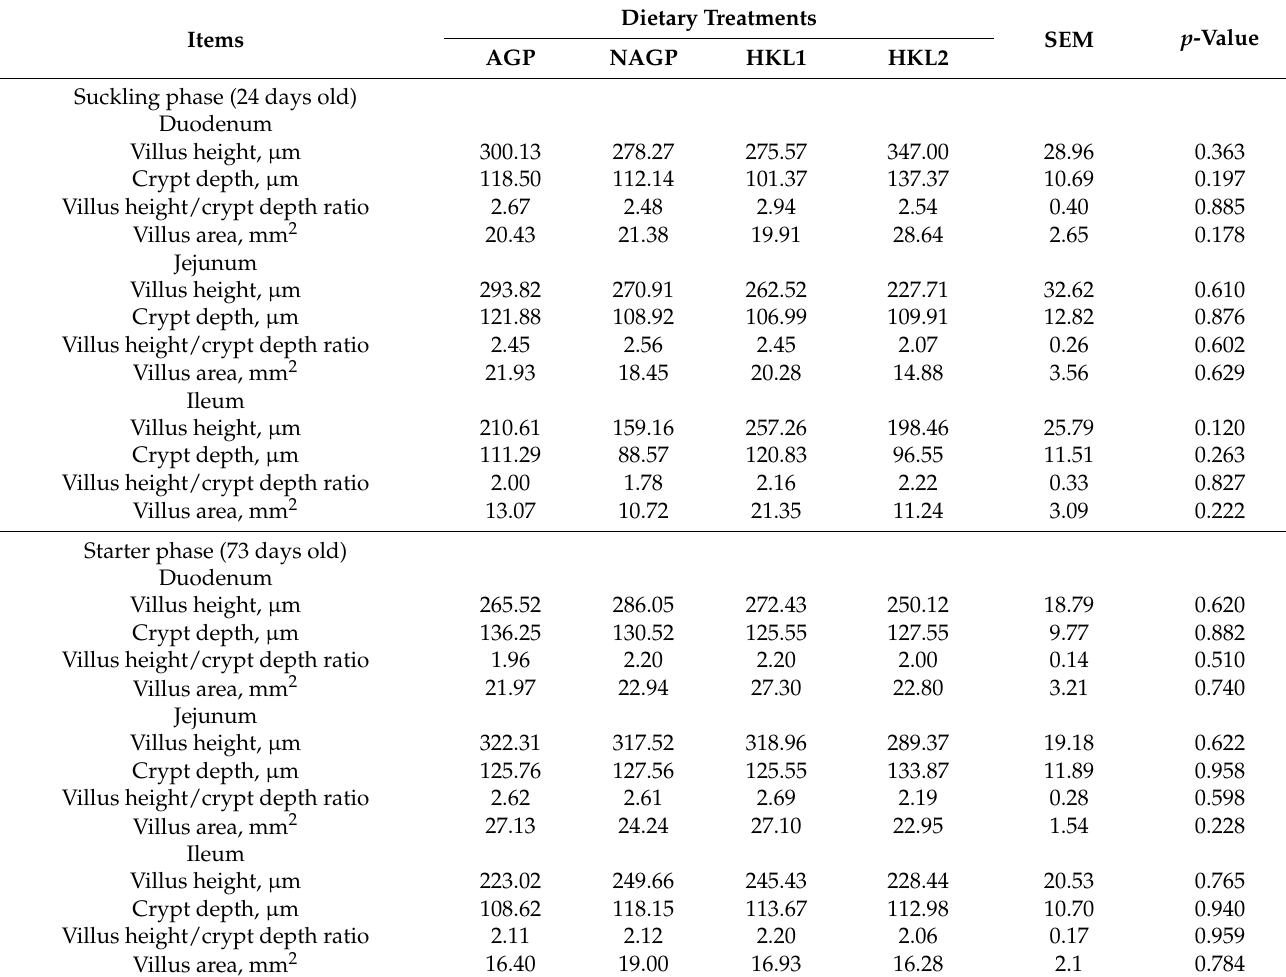
Table 7. Effects of the dietary treatments on the small intestine (duodenum, jejunum, and ileum) histology of suckling pigs (24 days